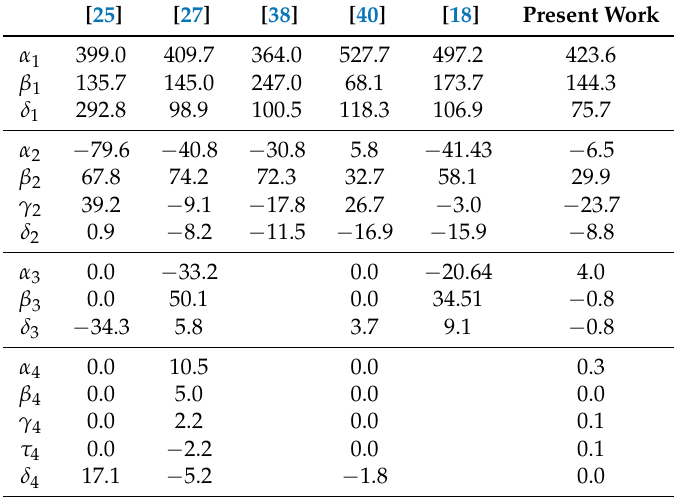
Table 1. Parameters of the force constants models [ N / m ] by Wirtz et al. [25], Tewary et al. [27], Ariza et al. [38,40], Mendez et al. [18] and the present